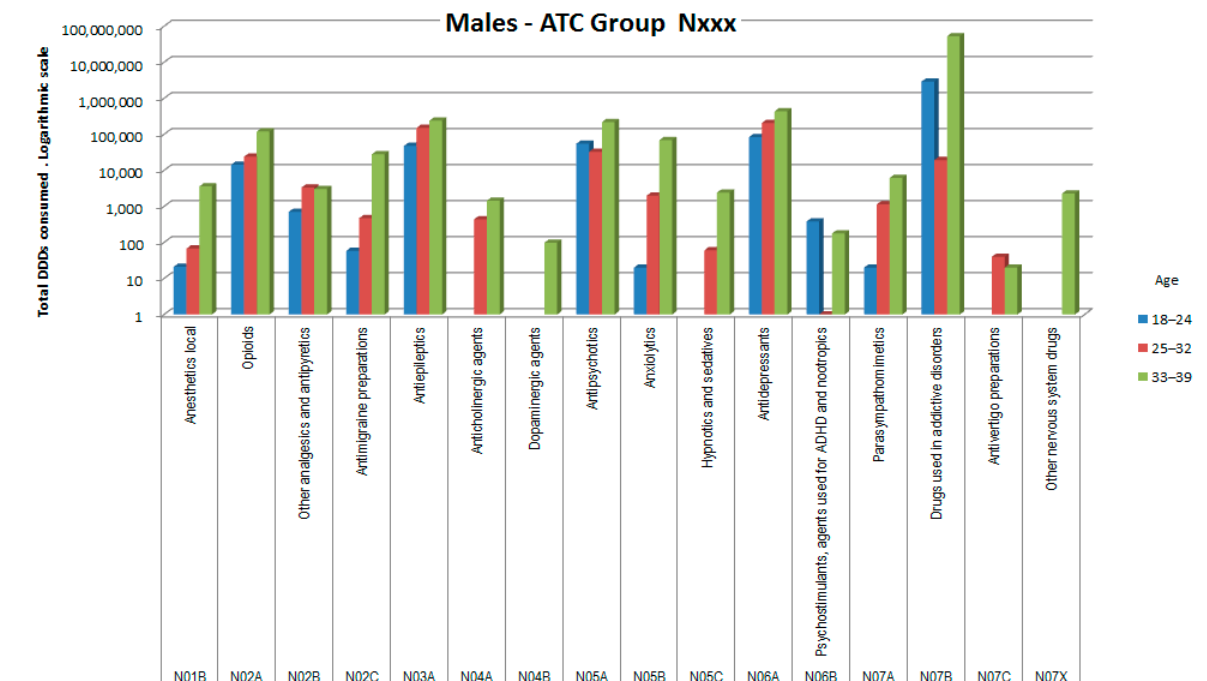
Figure 11. DDD consumption for females, ATC group Hxxx.